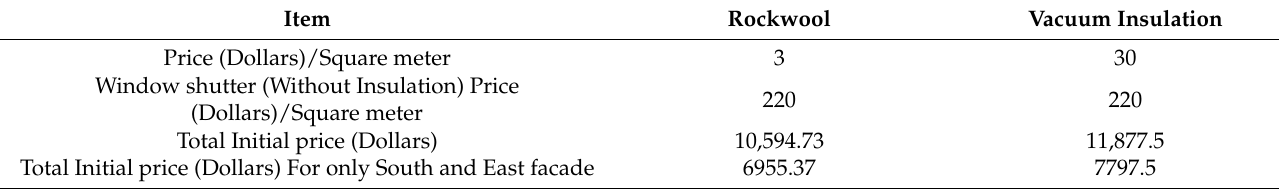
Table 8. Windows shutters insulations type